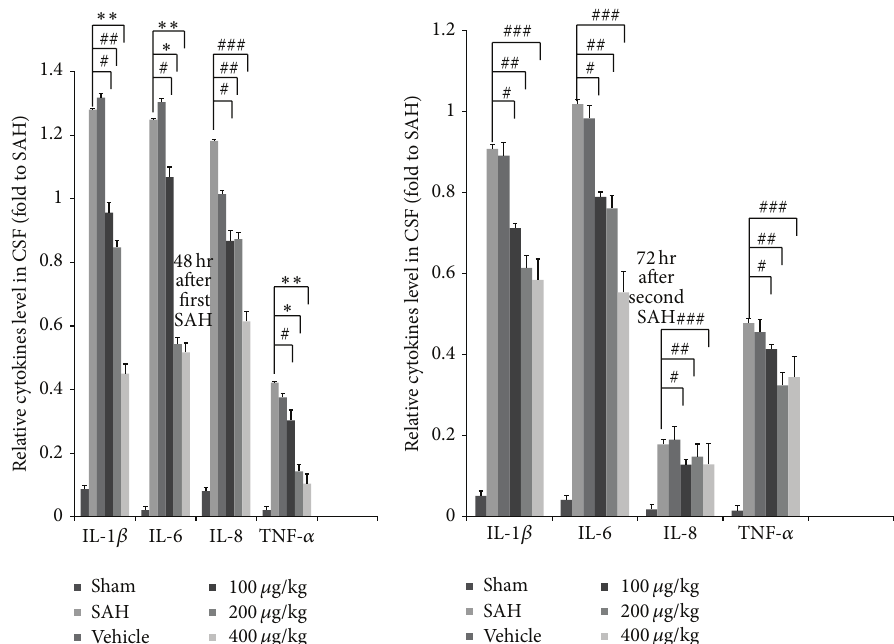
Figure 2: Bar graph depicting purpurogallin on the time-course change of proinflammatory cytokines after the induction of SAH. Data are depicted for IL-1 𝛽 , IL-6, IL-8, and TNF- 𝛼 at 48 hr after first SAH and 72 hr after second SAH. Data in the figure are presented as means ± SD ( 𝑛 = 9 ). ∗,∗∗ 𝑃 < 0.01 , and # , ## , ### 𝑃 > 0.05 when compared with the SAH group.